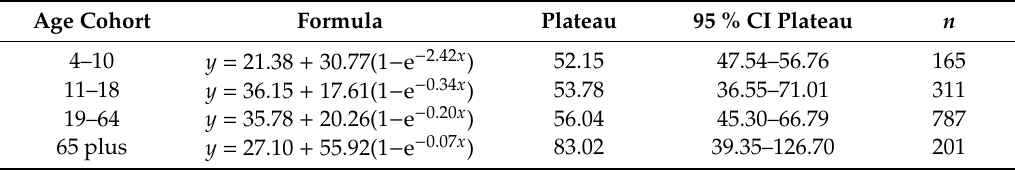
Table 3. Relationship between the amount of vitamin D consumed per day ( x : in µ g per day) and serum concentrations of 25(OH)D ( y ; in nmol / L). Data from the NDNS database before application of the model. Age Cohort Formula